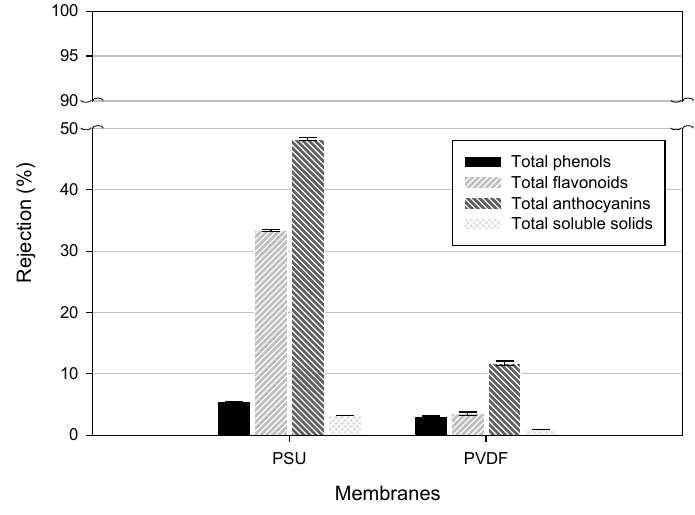
Figure 3. Rejection of PSU and PVDF HF membranes towards specific compounds of pomegranate juice.